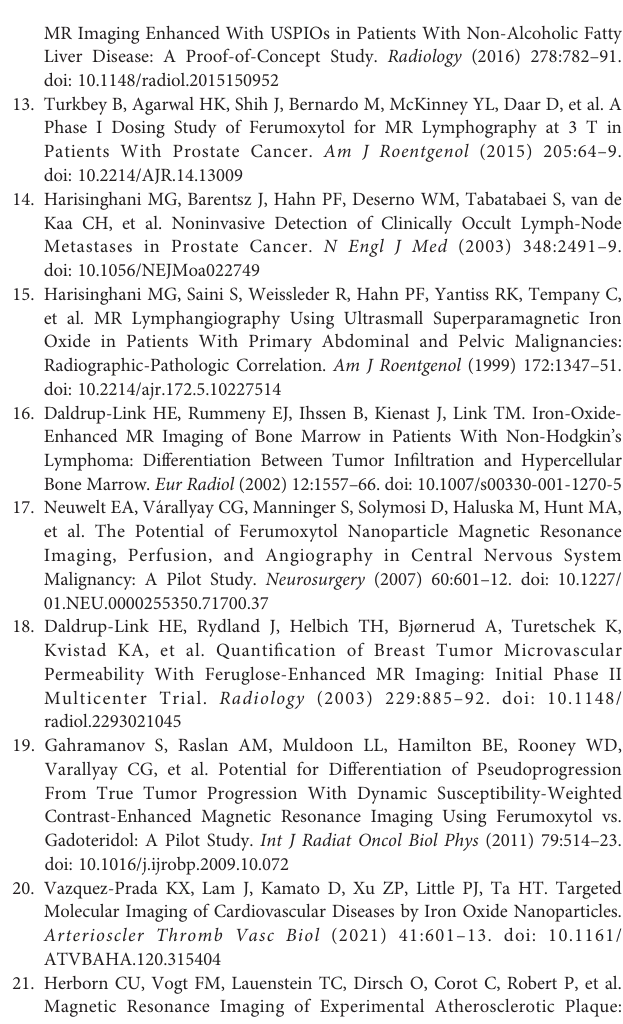
Supplementary Figure 1 | TEM (number-weighted) NP size distribution. Histograms representing the size distribution from TEM images. (A) AuNP SPH; (B) AuNP ROD (the distribution of both length and width are shown in the left and right panels, respectively); (C) FeOxNP 17; and d) FeOxNP 22. The red line in (C, D) is the best- fi t log-normal distribution. The size data are reported in the inserts and in Table 1 . Supplementary Figure 2 | DLS intensity-weighted distribution of the hydrodynamic diameter of AuNP SPH. Intensity-weighted distribution ( P I ) of the hydrodynamic diameter of AuNP SPH in WFI (black), PBS (blue) and RPMI-1640 after pre-treatment with human serum (red). Error bars are shown. The largest PI peak is centered at 16 nm for AuNP SPH in WFI, 15 nm for AuNP SPH in PBS, and 21 nm for AuNP SPH in RPMI-1640 after pre-treatment with human serum. Supplementary Figure 3 | AuNP uptake by monocytes. TEM images of AuNP SPH internalized by monocytes and associated within vesicles. Size bars are 1 mm in the left panel and 500 nm in the right